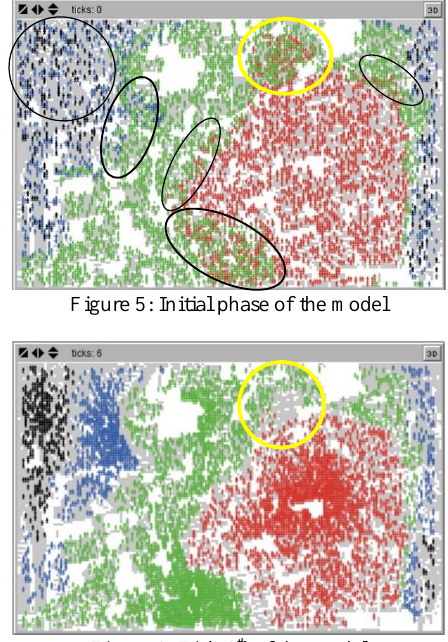
Figure 6: Tick 6 th of the